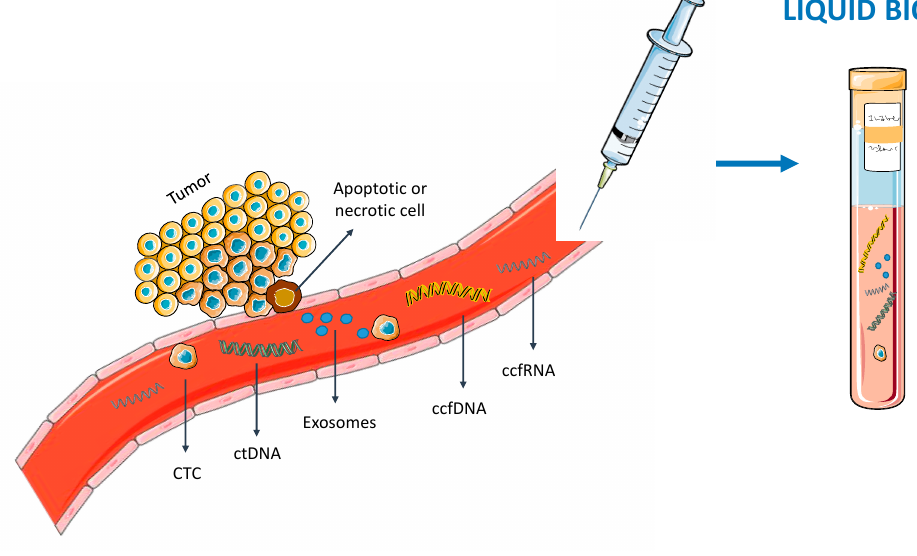
Figure 1. Blood-based liquid biopsy. Circulating tumor cells (CTC), circulating cell-free DNA (ccfDNA) [including circulating tumor DNA (ctDNA)], circulating cell-free RNA (ccfRNA) and exosomes are released from tumor cells to the bloodstream. Hence, blood can be collected and analyzed in the context of a liquid biopsy.